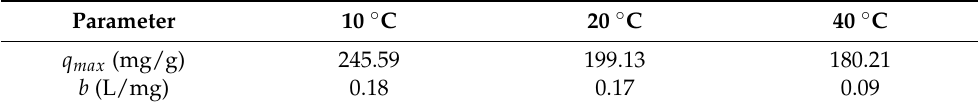
Table 4. Langmuir isotherm parameters at 10 ◦ C, 20 ◦ C, and 40 ◦ C for AV0.